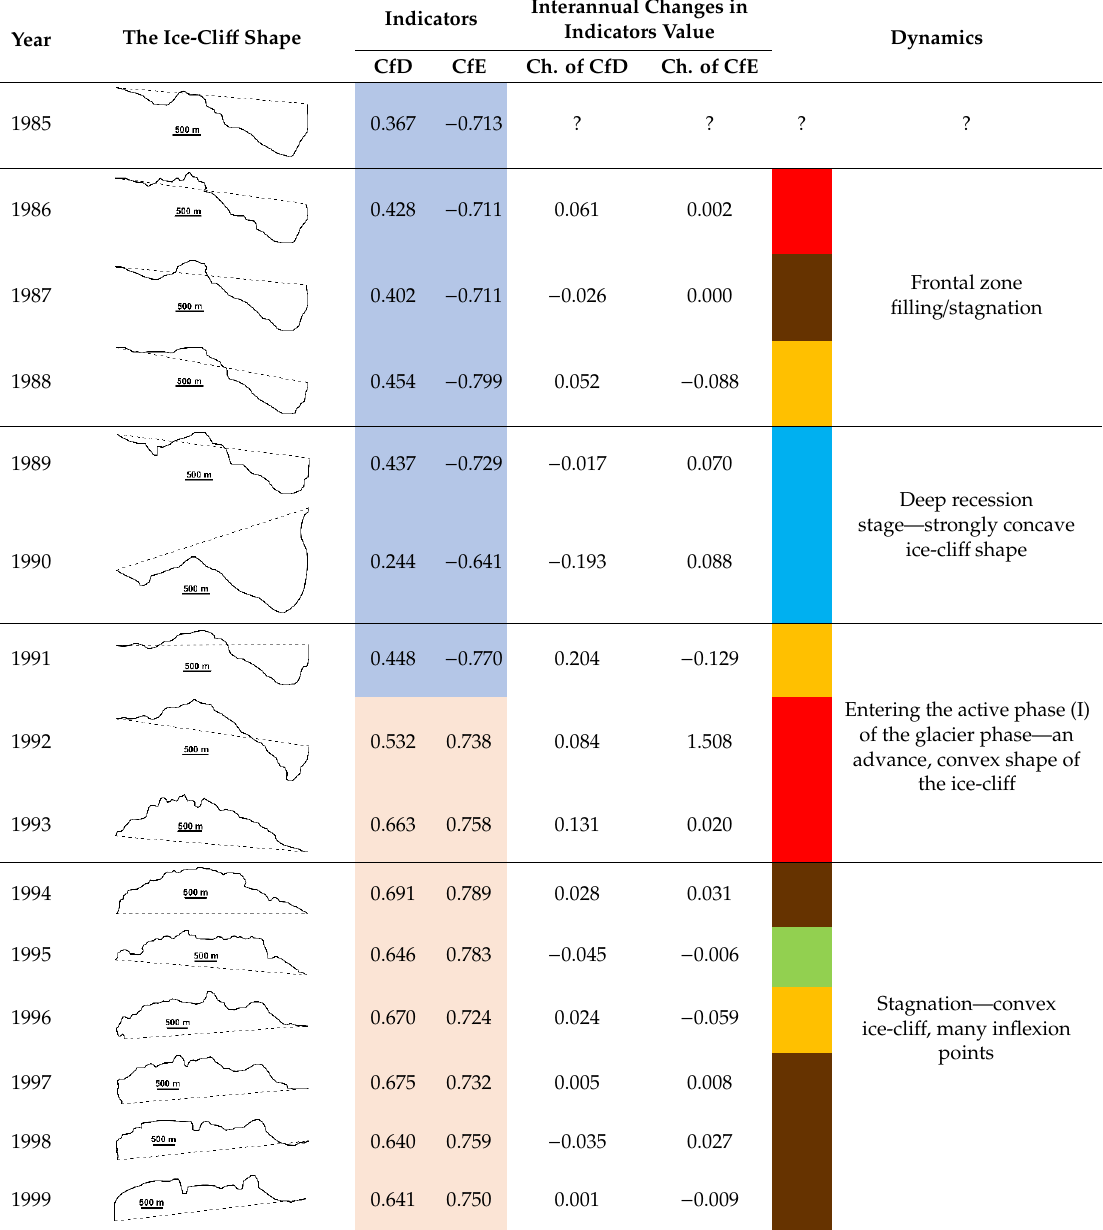
Table 4. Characteristics of Monacobreen dynamics based on CfD and CfE indicators and their interannual changes in